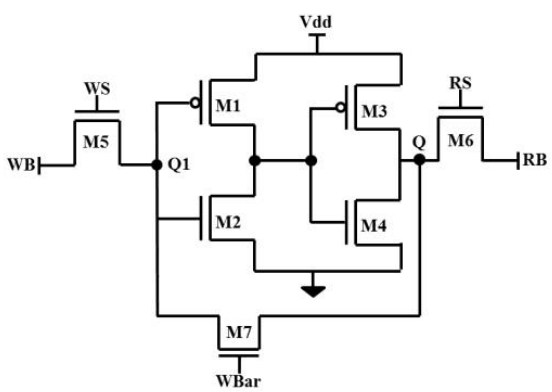
Figure 4. Traditional 7T - SRAM cell.